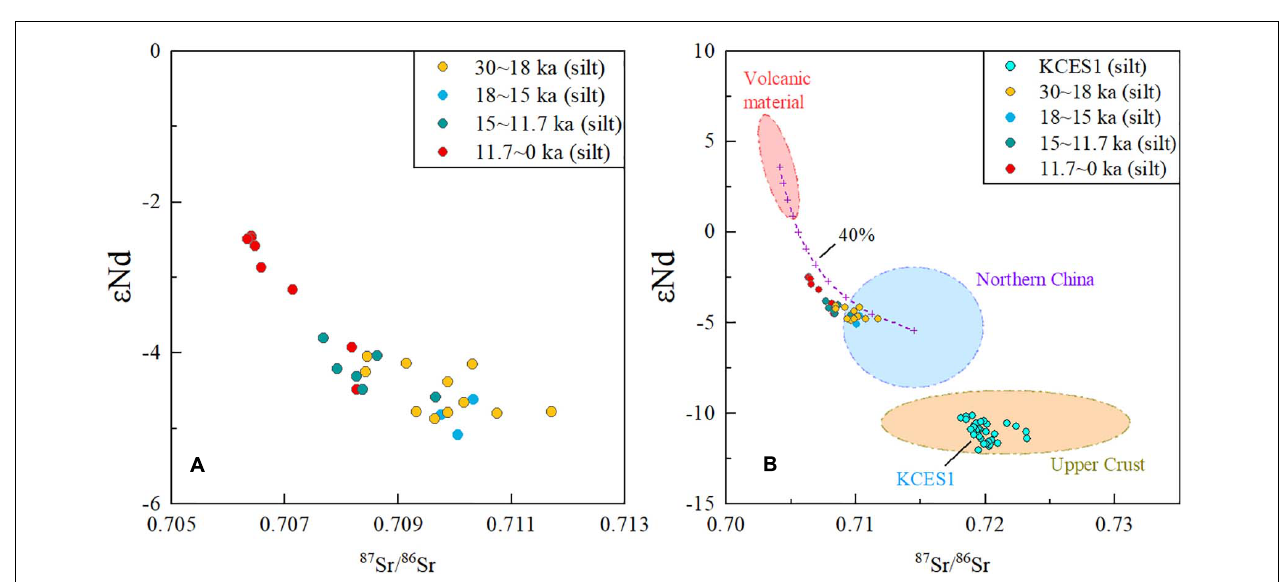
FIGURE 8 | Discrimination plots of (Gd/Yb) N v.s. (La/Sm) N (A) and (LREE/REE) N v.s. (HREE/REE) N (B) for the sediments of this study. Values of modern riverine sediments of Yangtze and Yellow Rivers (Yang et al., 2002), Japan Arc (Togashi et al., 2000), Northeast China desert (Xie et al., 2019), Chinese Loess Plateau (Jahn et al., 2001), and Taklimakan desert (Yang X. et al., 2007) are also shown for comparison.